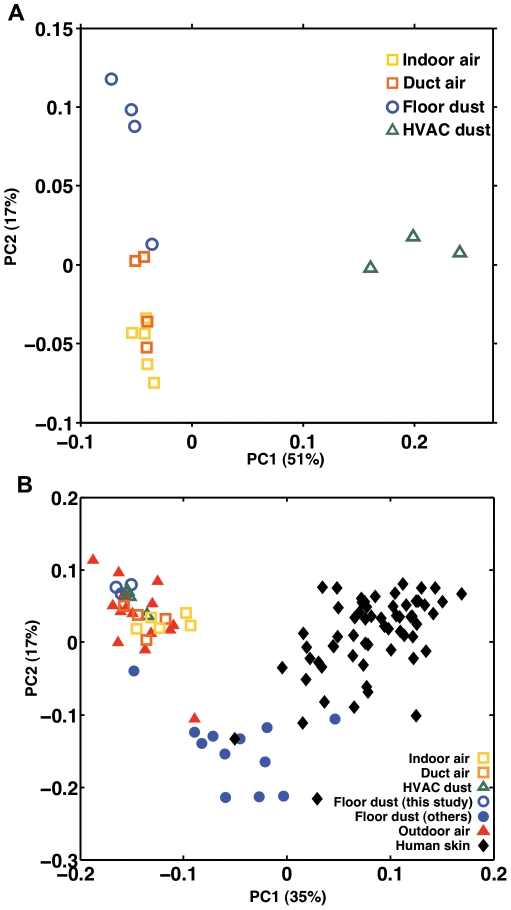
Comparison of indoor bacterial populations.(A) Weighted UniFrac-based bacterial diversity principal coordinate analysis of indoor air (yellow outlined squares), ventilation duct supply air (orange outlined squares), floor dust (outlined circles) samples, and HVAC filter dust samples (outlined triangles) from this study. (B) UniFrac-based bacterial diversity principal coordinate analysis displaying the two coordinates that explain most of the variation between samples from this study (open squares, circles, and triangles) and the bacterial ecology of human skin samples (filled diamonds) from Costello et al. [31], outdoor air samples (filled triangles) from Bowers et al. [33], and floor dust samples from Täubel et al. [20] and Rintala et al. [27] (filled circles).